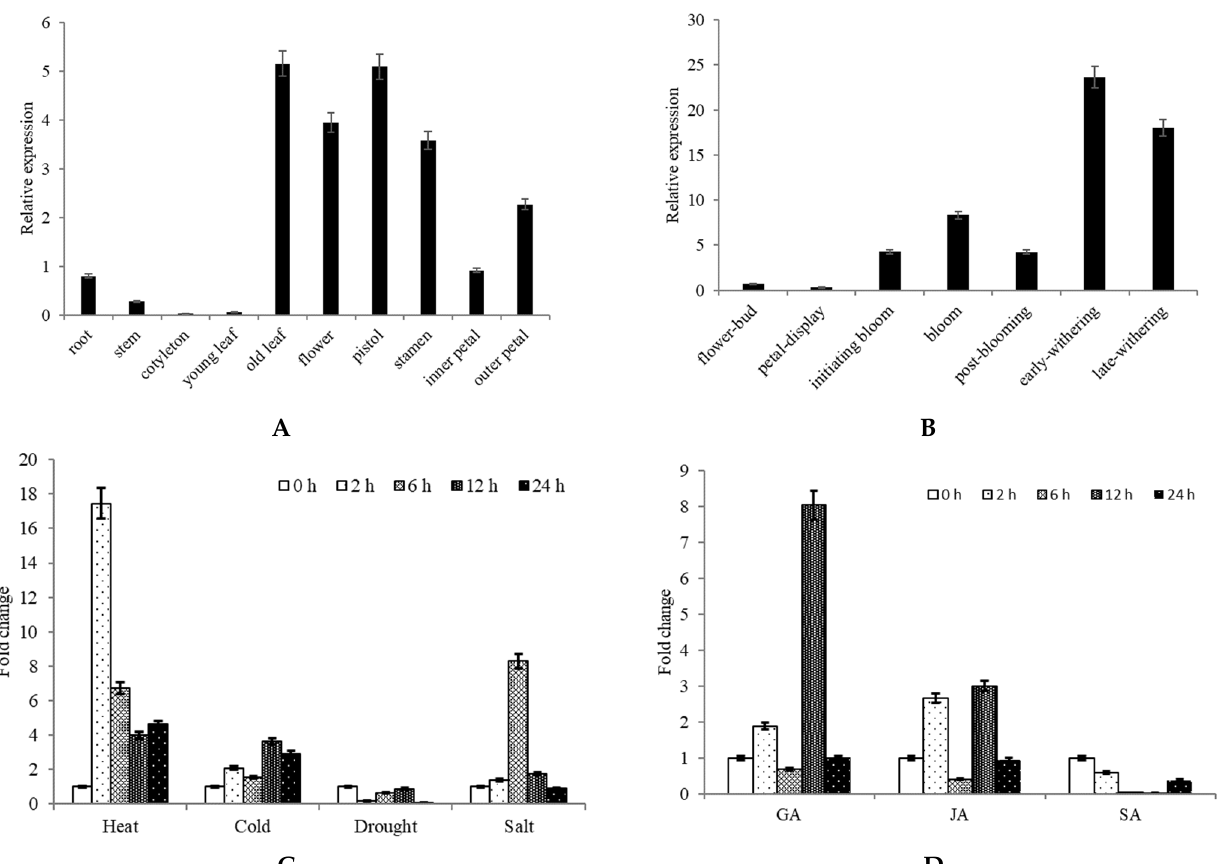
Figure 3. Analysis of CpNAC68 expressions by qRT-PCR. ( A ) Expressions in different tissues and flora organs. ( B ) Flower development stages. ( C ) Stress treatments (heat, cold, drought, salt) at indicated time points. ( D ) Hormone treatments (GA, JA, SA) at indicated time points. Expression levels were normalized by CpActin . Data represent the mean of three biological repeats ± SD. Error bars indicate the standard deviation.